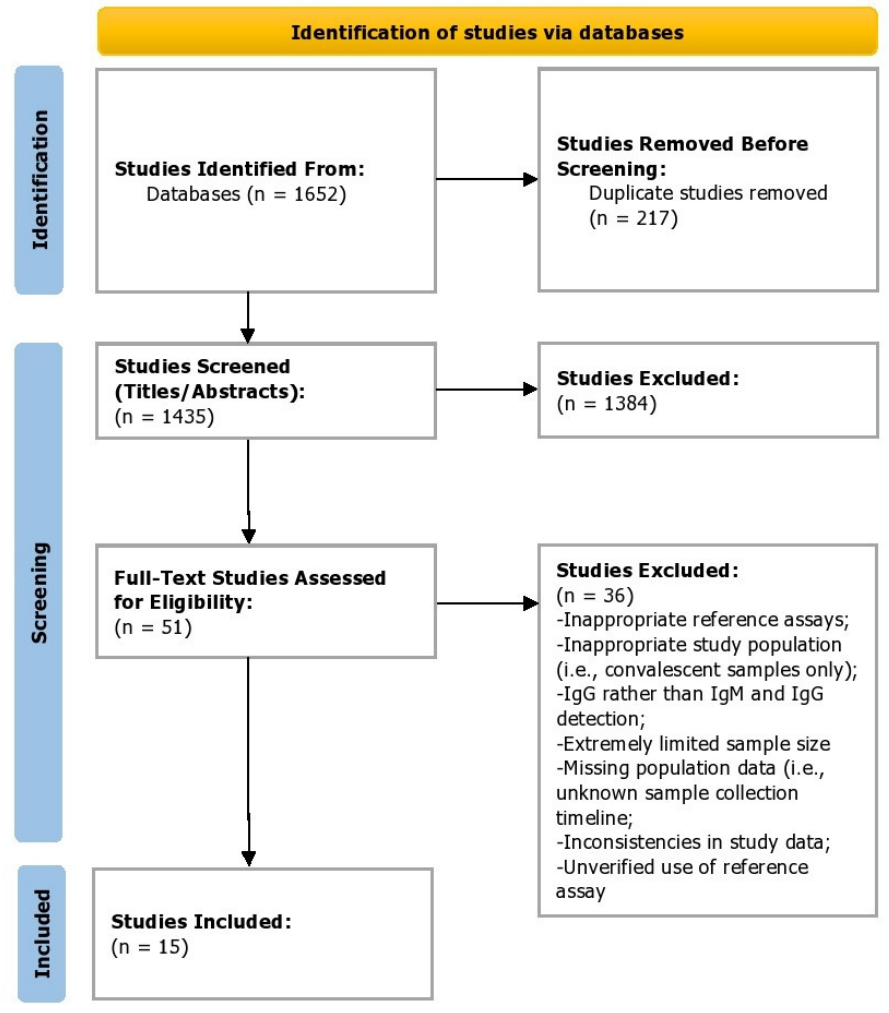
Figure 1. PRISMA flowchart of the study selection process.